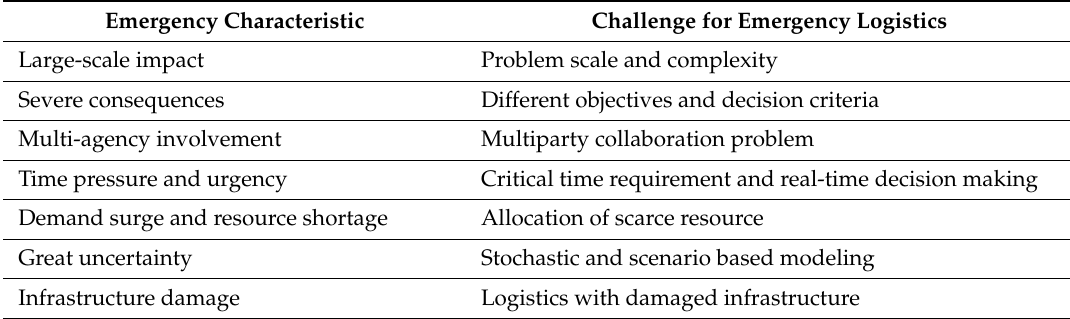
Table 3. Challenges for emergency